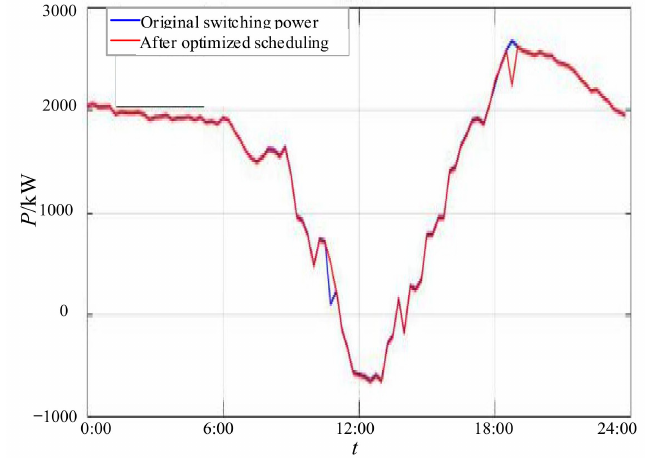
Figure 7. Exchanging power between AC/DC hybrid distribution network and AC main network without power electronic